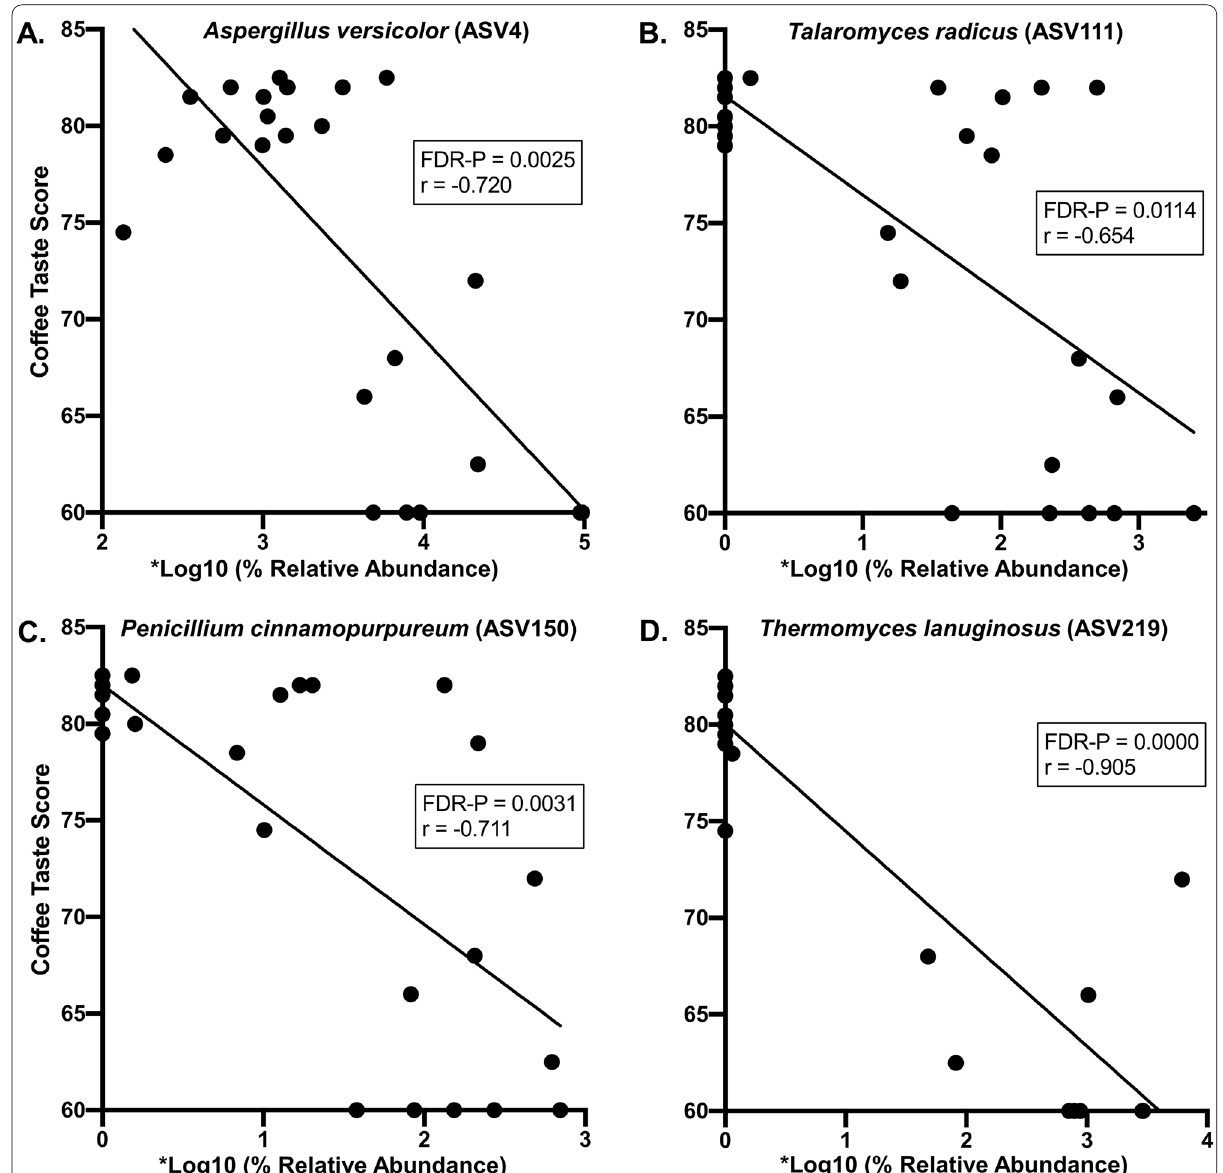
Fig. 2 Abundant fungi that negatively correlated with coffee taste scores. Pearson correlation analyses were used to identify the abundant fungal ASVs that negatively correlated with coffee taste scores. Average ASV relative abundances were obtained using an Illumina‑based sequence analysis of the fungal rRNA ITS region. *Relative abundance values were multiplied by 269,972 before the log10 operation such that the final non‑zero values were greater than zero. ASV numbers are indicated in parentheses to the right of the taxa names. The average relative abundances of these fungi were: ASV4, 3.4%; ASV111, 1.5%; ASV 150, 1.3%; ASV219, 1.1%. Correlation coefficient (r) and probability value (P) are shown (n